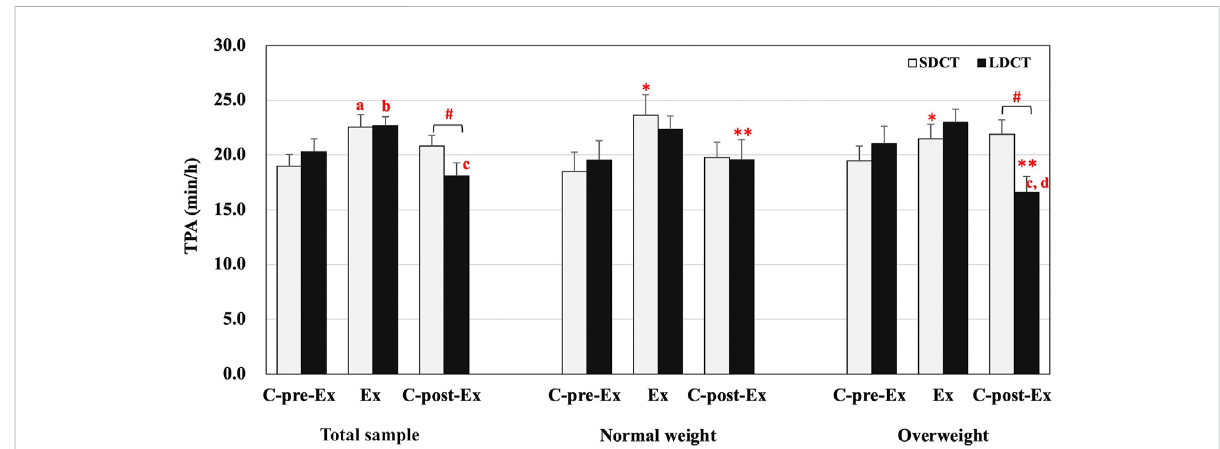
FIGURE 2 Total physical activity in thetotal sample, normal and overweightgroups. Data are expressedas themean ± SEM. *Main effect of time for SDCT in the Ex period compared with C-pre-Ex period, p < 0.05. **Main effect of time for LDCT in the C-post-Ex period compared with C-pre-Ex and Ex periods, p < 0.05. # Signi fi cantdifferencebetweenSDCTandLDCTintheC-post-Experiod, p < 0.05. a Signi fi cantlydifferentfromSDCTintheC-pre- Ex period, p < 0.05. b Signi fi cantly different from LDCT in the C-pre-Ex period, p < 0.05. c Signi fi cantly different from LDCT in the Ex period, p < 0.05. d Signi fi cantly different from LDCT in the C-pre-Ex period, p < 0.05. Abbreviations: SEM, standard error of the mean; SDCT, short-duration continuous training; LDCT, long-duration continuous training; C-post-Ex, two-day follow-up period; C-pre-Ex, two-day baseline observation period; Ex, three-day exercise intervention period.